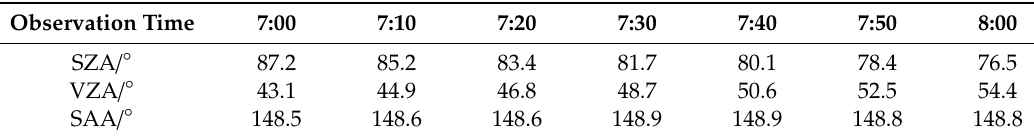
Table 5. Observation conditions change over time.